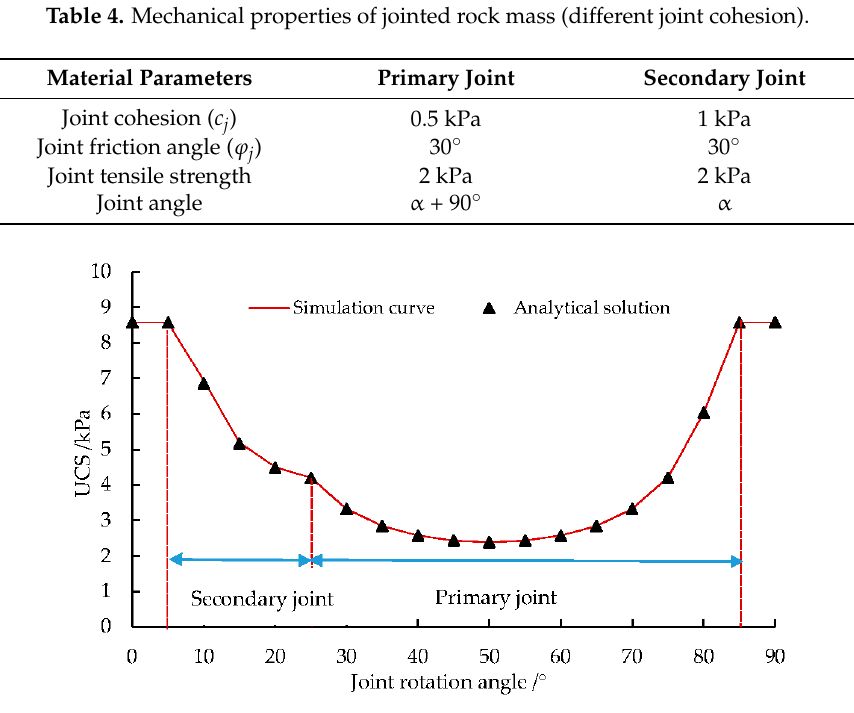
Figure 15. Failure envelope for sample with different friction values (see Table 3).